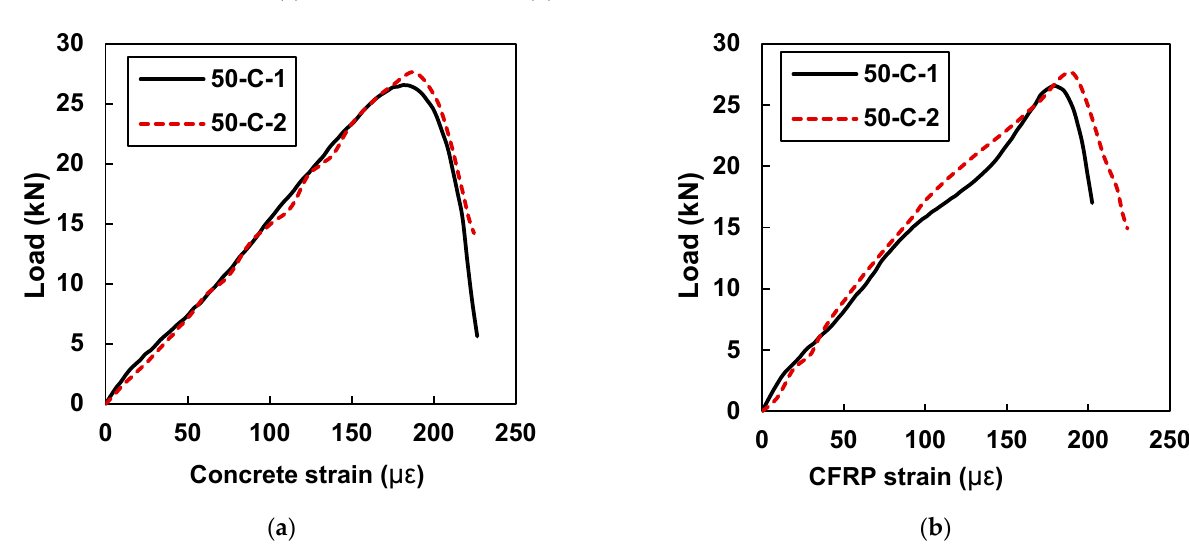
Figure 16. Load vs. strain curves for specimens with 40 mm CFRP strips (40-C-1 and 40-C-2): ( a ) strain in concrete and ( b ) concrete strain in CFRP.